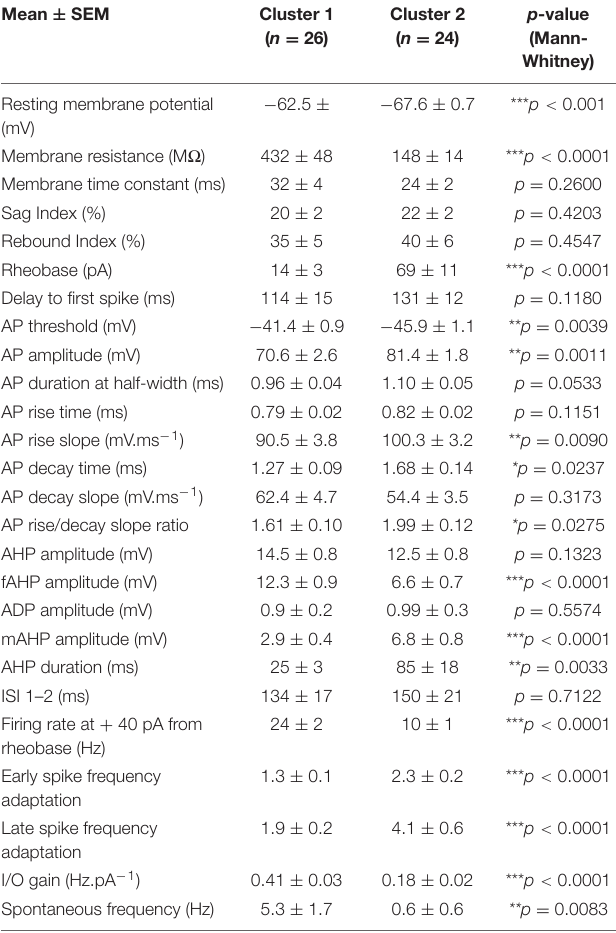
TABLE 3 | Electrophysiological